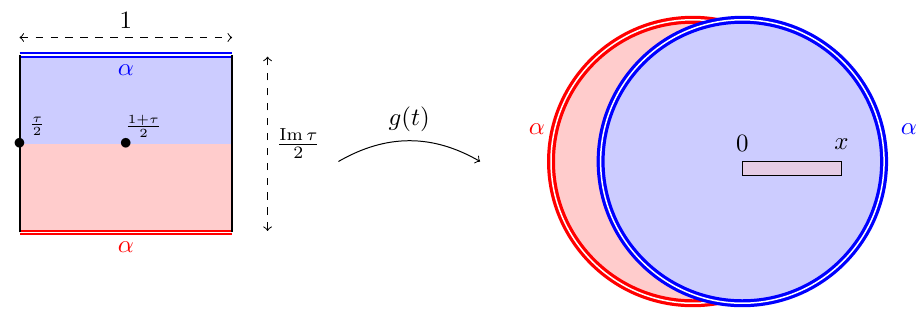
Figure 2: The annulus (cid:65) τ – fundamental domain pictured here – is mapped through g to the two-sheeted disk (cid:68) . The black edges are identified. 2, x ( α , α ) The strategy (adapted from [ 49 ] ) to compute 〈 σ ( 0,0 ) σ ( x , ¯ x ) 〉 (cid:68) in terms of an annulus